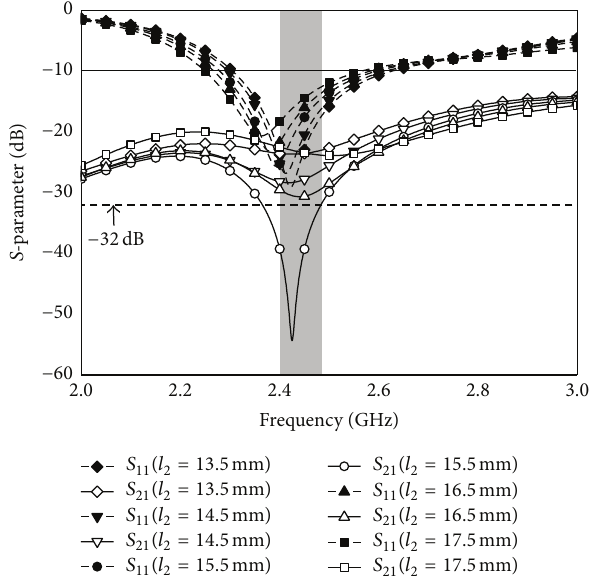
Figure 6: Simulated 𝑆 -parameters for various values of length 𝑙 2 ( 𝑙 1 = 27.5